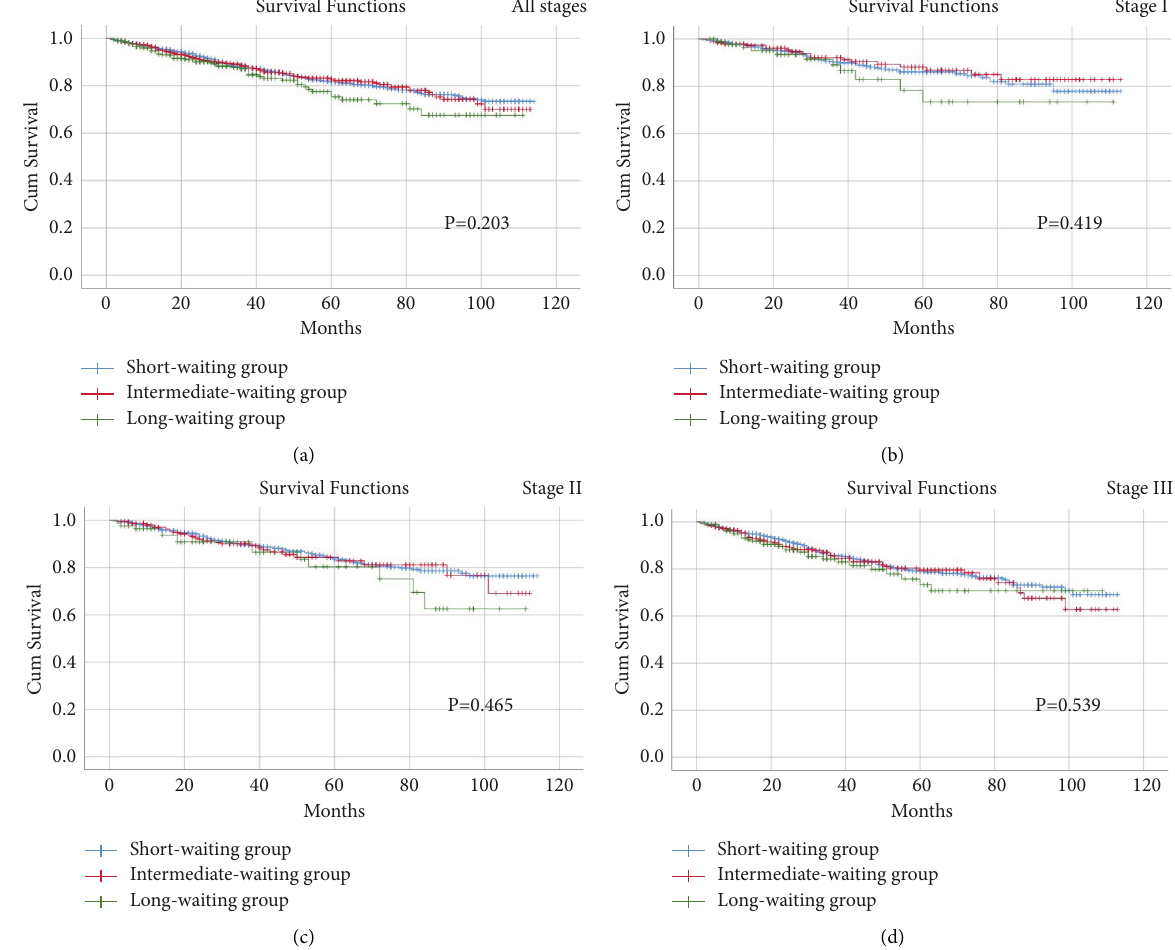
Figure 2: Overall survival among three groups, including short-waiting group, intermediate-waiting group, and long-waiting group. (a) stage I; (b) stage II; (c) stage III; (d) stage